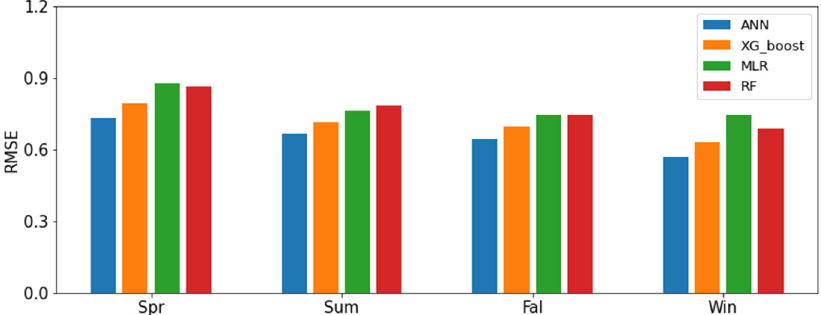
Figure 5. The average RMSE of the OST estimated by four different models for four seasons at 26 depth levels in 2016.